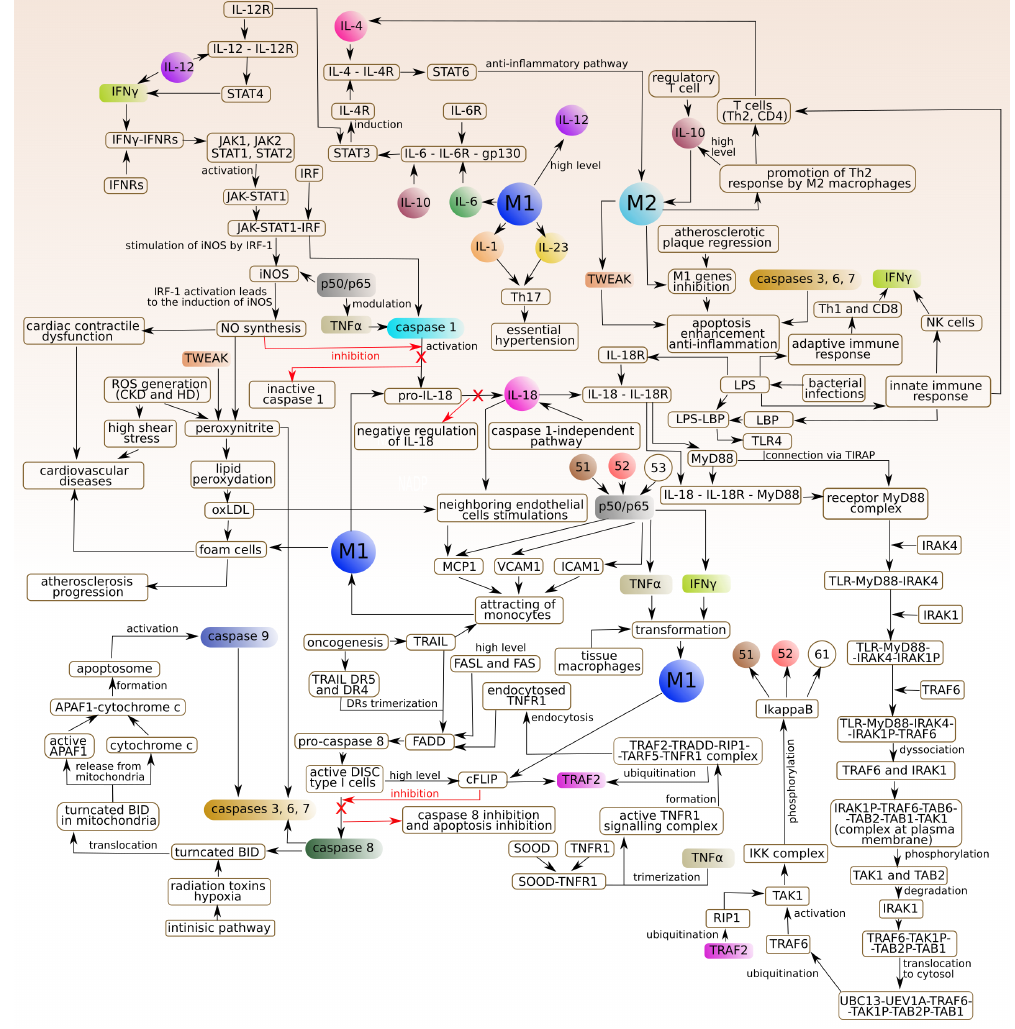
Figure 4. The diagram of the phenomena underlying the atherosclerotic lesions formation. The elements which are marked with the same colour and name correspond to the same particle (logic place). Element “51” corresponds to p50/p65 proteasome inhibitors induce inhibitory κ B (I κ B) phosphorylated complex within macrophages. Element “52” corresponds to p50/p65 dimer nuclear factor kappa-light-chain-enhancer of activated B cells (NF- κ B) early phase in activated endothelial cell (EC) in atherosclerosis. Element “53” corresponds to p50/p65 dimer nuclear factor kappa-light-chain-enhancer of activated B cells (NF- κ B)) early phase in activated smooth muscle cells (SMC). Element “61” corresponds to p50/p65 proteasome inhibitors induce inhibitory κ B (I κ B) phosphorylated complex in activated SMC. Element “p50/p65” corresponds to p50/p60 translocation to the nucleus in macrophages M1 and SMC and endothelial cells